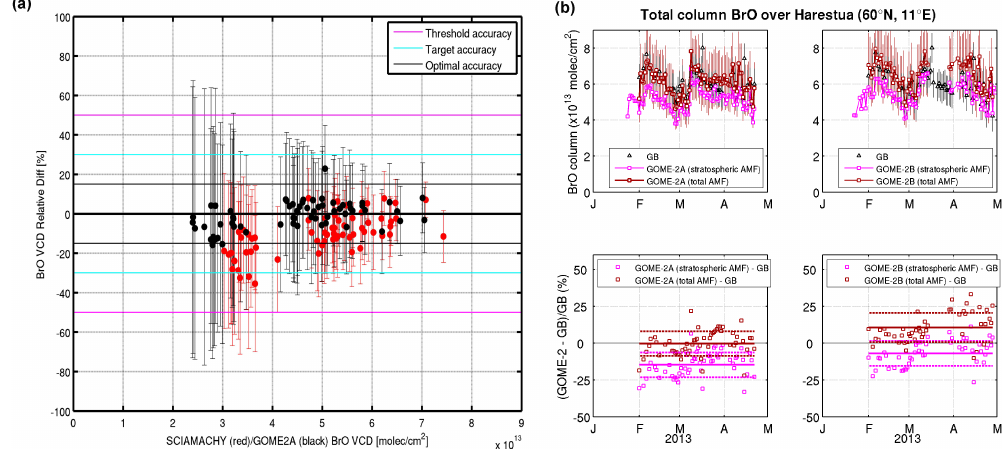
Figure 15. Example of BrO validation: (a) Monthly averaged BrO VCD relative difference between GOME-2B (red) and GOME-2A (black) against SCIAMACHY as a function of SCIAMACHY/GOME-2A BrO VCD, for 14 sites from pole-to-pole over the period December 2012– April 2013. (b) Comparison of GOME-2 (A and B) and ground-based total BrO columns at Harestua (60 ◦ N, 11 ◦ E) in February–April 2013. The satellite results labelled “total AMF” are calculated using the stratospheric and tropospheric AMFs weighted by the BrO column con- tribution in both layers as retrieved from the ground-based measurements. The relative differences (squares) and mean biases (solid lines) appear in the lower plots. The number of coincidences is 55 for GOME-2A and 49 for GOME-2B.